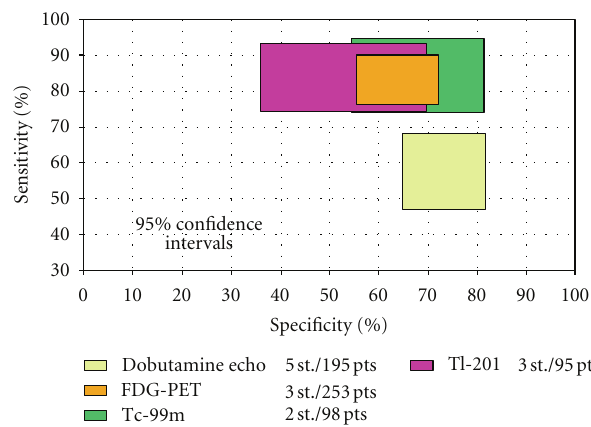
Figure 3: Sensitivity and specificity of thallium rest redistri- bution (Tl RR), Tc-99m sestamibi (MIBI), FDG-PET, low-dose dobutamine echocardiography (LDDE), dobutamine MRI (Db- MRI) and contrast-enhanced MRI (CE-MRI) for the prediction of viability (with permission from Marwick T (2003) Heart, BMJ Publishing Group, British cardiac society [110]).